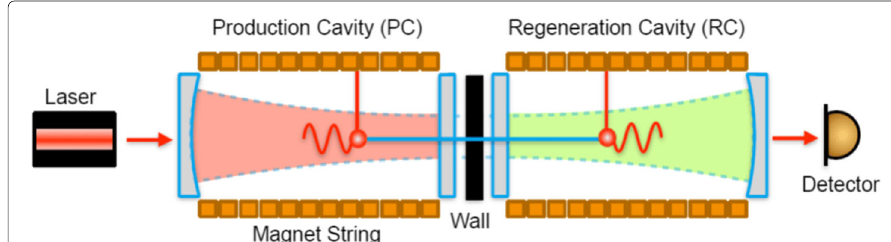
Fig. 2 Schematic layout of the experiment. The probability for the generation of an ALP by a photon gets increased in an optical resonator. Behind the light tight wall a second optical resonator increases the probability of re-conversion to a photon in the magnetic field. (Figure from Aaron Spector)